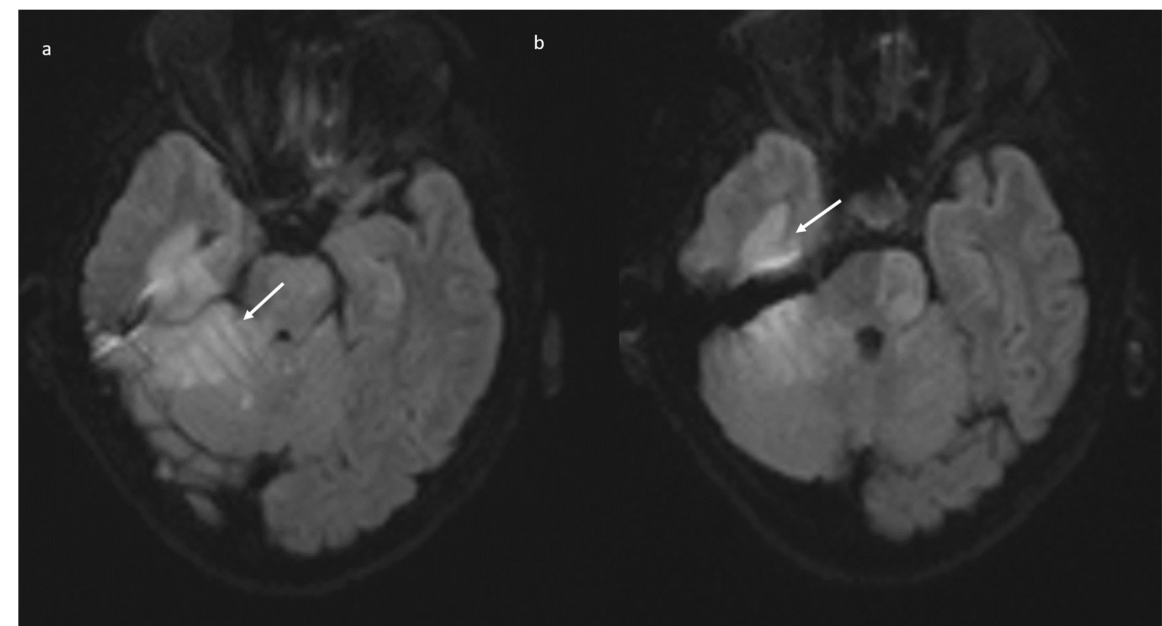
Figure 6. Brain MRI (DWI): acute ischemic lesion with restricted diffusion involving the pons, mesencephalon, the right superior cerebellar hemisphere with the vermis ( a ), and the right posterior temporal lobe ( b ).